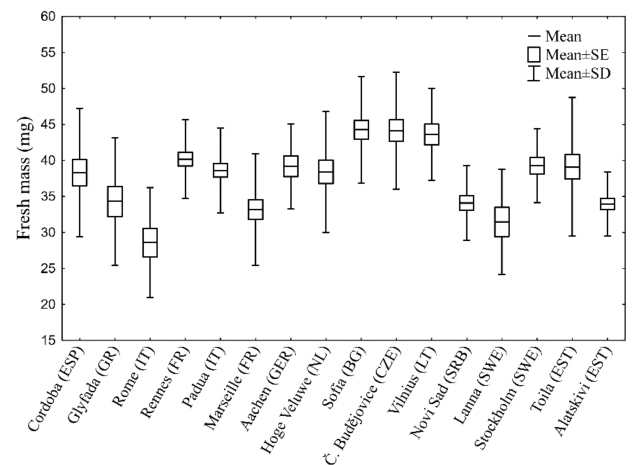
Figure 2. Variation in fresh mass among populations (the localities are ordered by decreasing minimal winter temperature). See Table 1 for sample